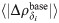
Phase-locking modulations induced by regional stimulation at WP3 and their associations with network properties.(A) Pairwise changes in the PLV inside the baseline band Δρbase when region i (Left) or region j ≠ i (Right) is perturbed. In this figure, regions i and j correspond to regions 10 (R–Precentral) and 15 (R–Isthmus), respectively. (B) Network-averaged absolute PLV changes in the baseline band 〈|Δρδibase|〉 induced by stimulation of different brain areas. (C) The quantity 〈|Δρδibase|〉
vs. structural node strength sistruc (Left) and vs. functional node strength sistruc (Right). Insets indicate Spearman correlation coefficients between the plotted quantities and their associated p-values).